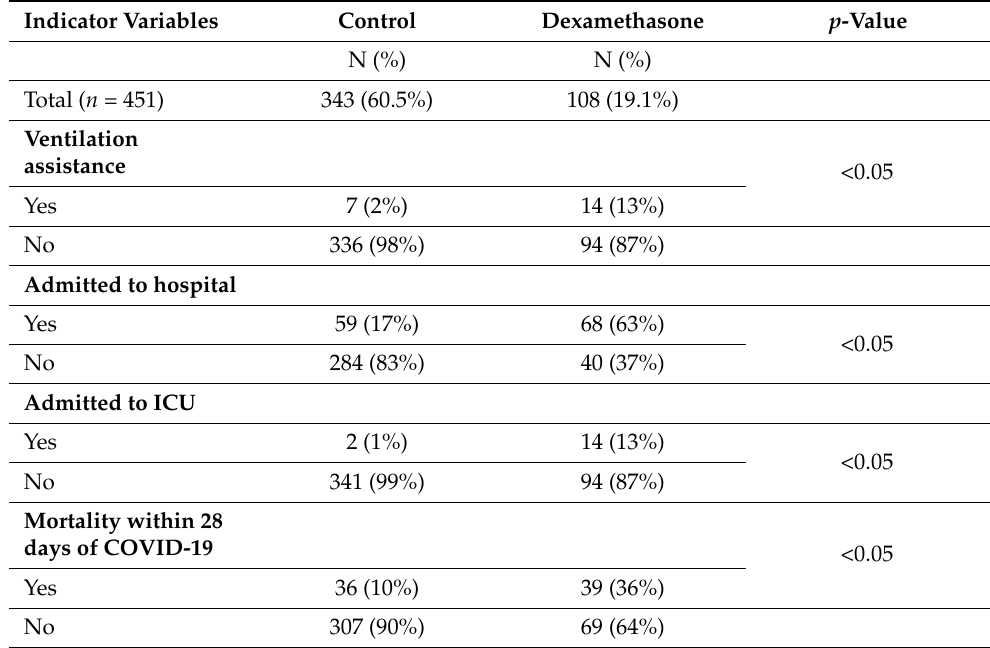
Table 2. Indicator variables of the study population.